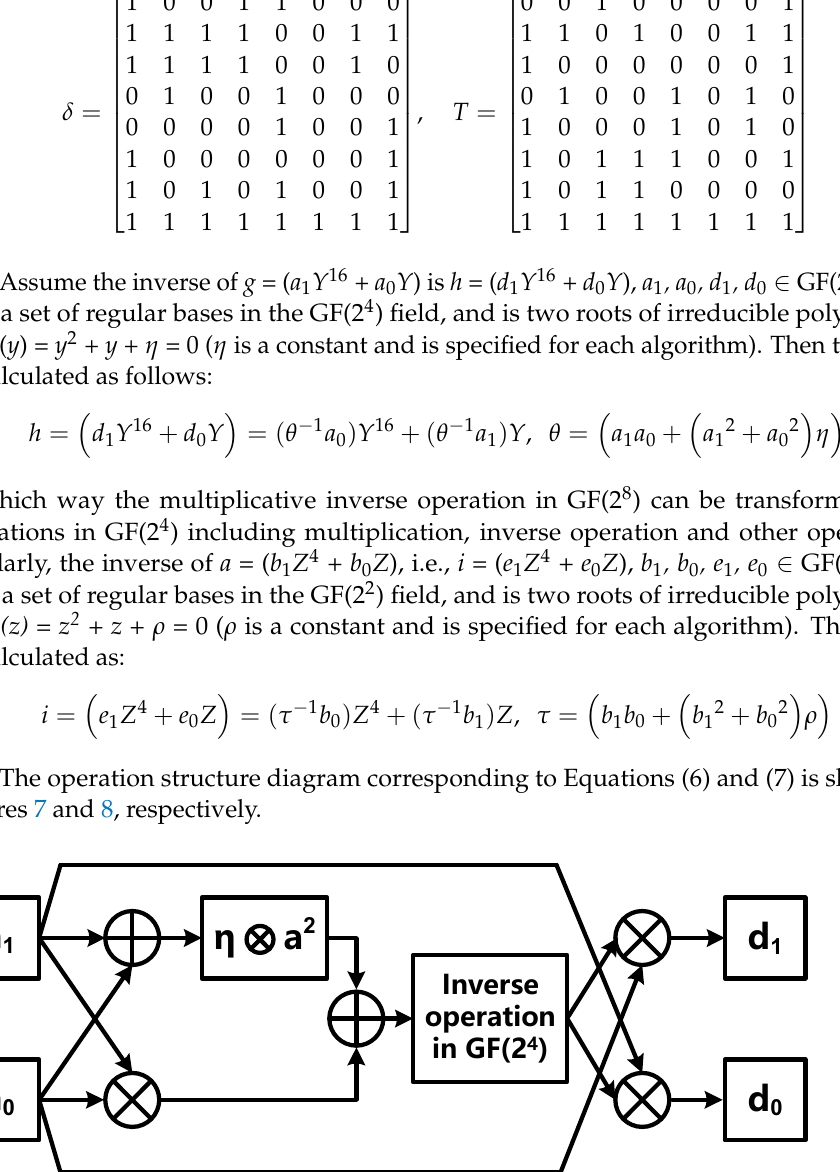
Figure 7. Multiplicative inverse operation of GF(2 8 ) based on regular basis.